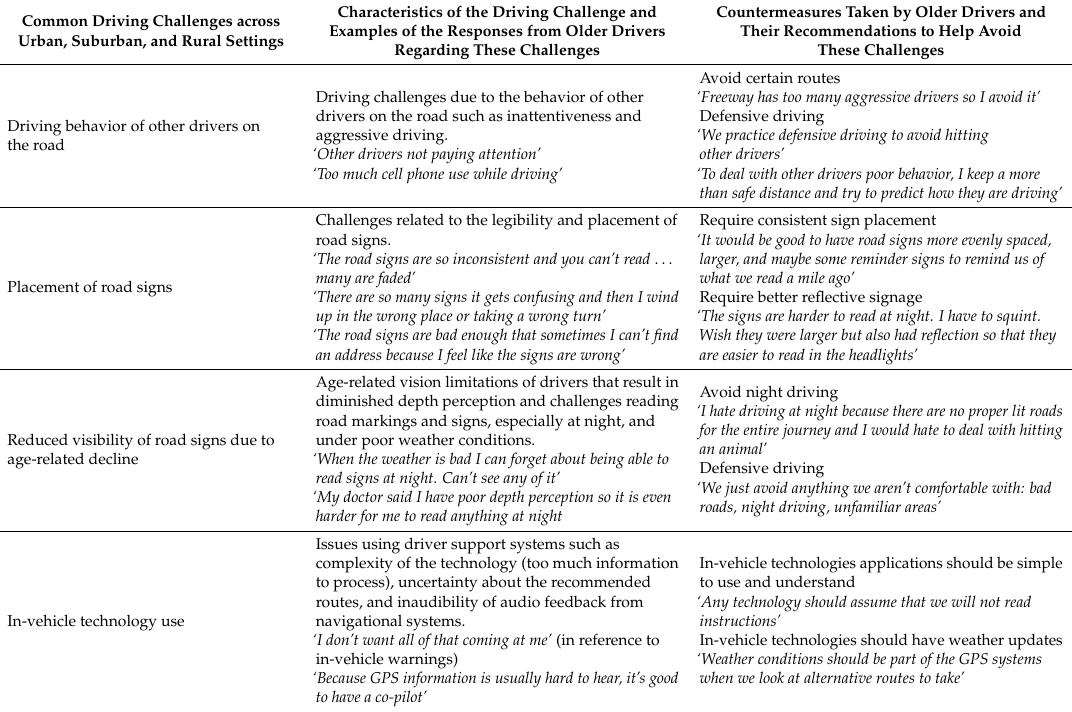
Table 2. Common driving challenges of older drivers and the strategies implemented to overcome their driving challenges in urban, suburban, and rural